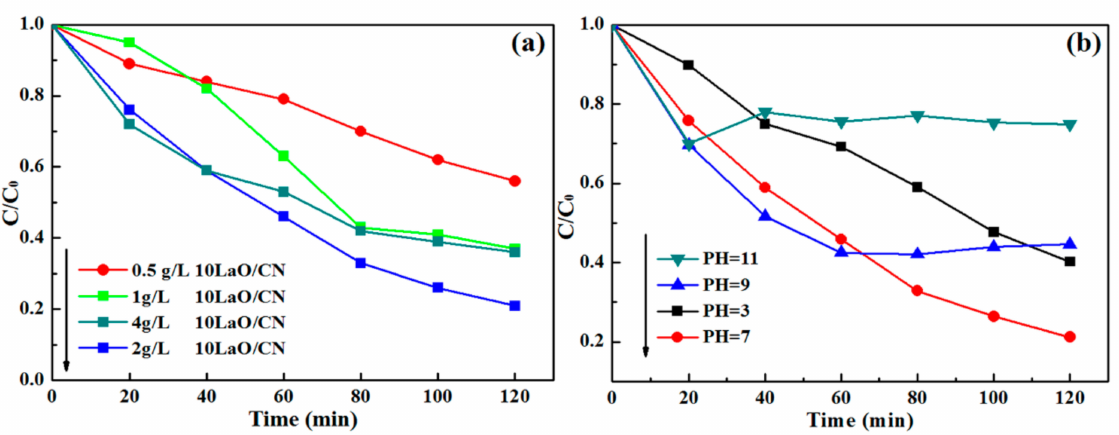
Figure 8. Different factors influencing photocatalytic activities for 10LaO/CN degraded TTCH: different concentration ( a ); pH value ( b